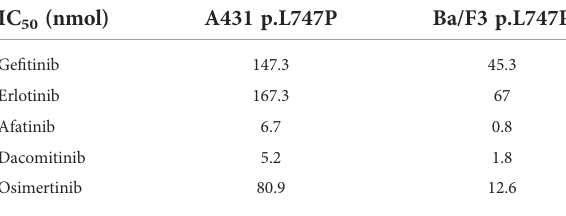
TABLE 1 Kinase inhibition activity of diverse EGFR TKIs against Ba/F3 and A431 p.L747P cell lines (7,